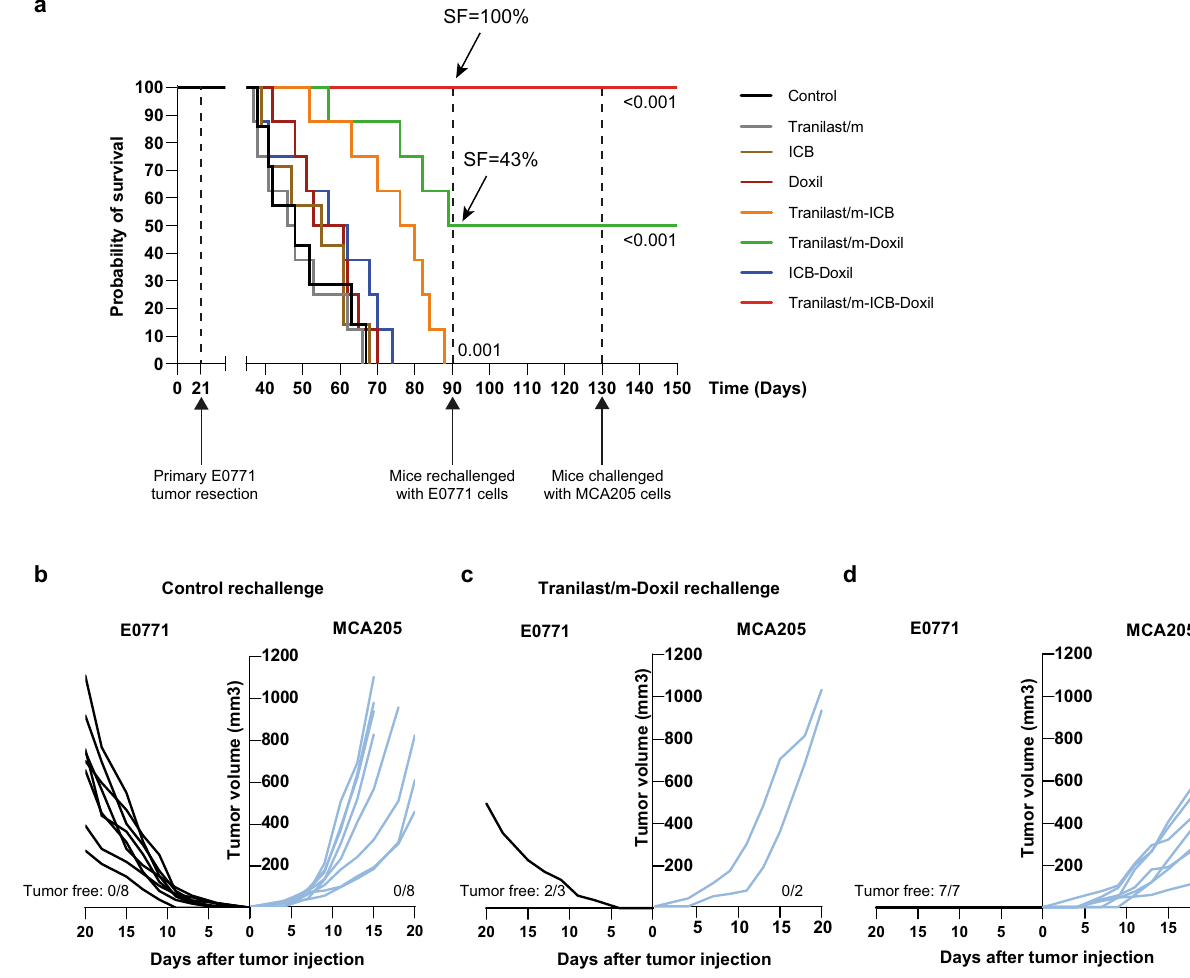
Fig. 7 | Speci fi city and longevity of antitumor response elicited by the combi- nation of Tranilast/m with nano-immunotherapy. a Kaplan – Meier survival curves for the various treatments considered ( n =7 – 8 mice). Arrows indicate the survivalfraction(SF) of mice atday 90.Statisticalanalysiswas performed bya log- rank (Mentel-Cox) test comparing the treated groups with the control. C57BL/6 female mice were orthotopically injected with 5 × 10 4 E0771 cells on day 0 and subsequentlytreatedasindicated.Primarytumorsweresurgicallyremovedonday 21andmiceweredailymonitoredfortheirsurvivalrate.Onday90,survivorsofthe Tranilast/m-Doxil( n =3)andTranialst/m-ICB-Doxil( n =7)groupwererechallenged